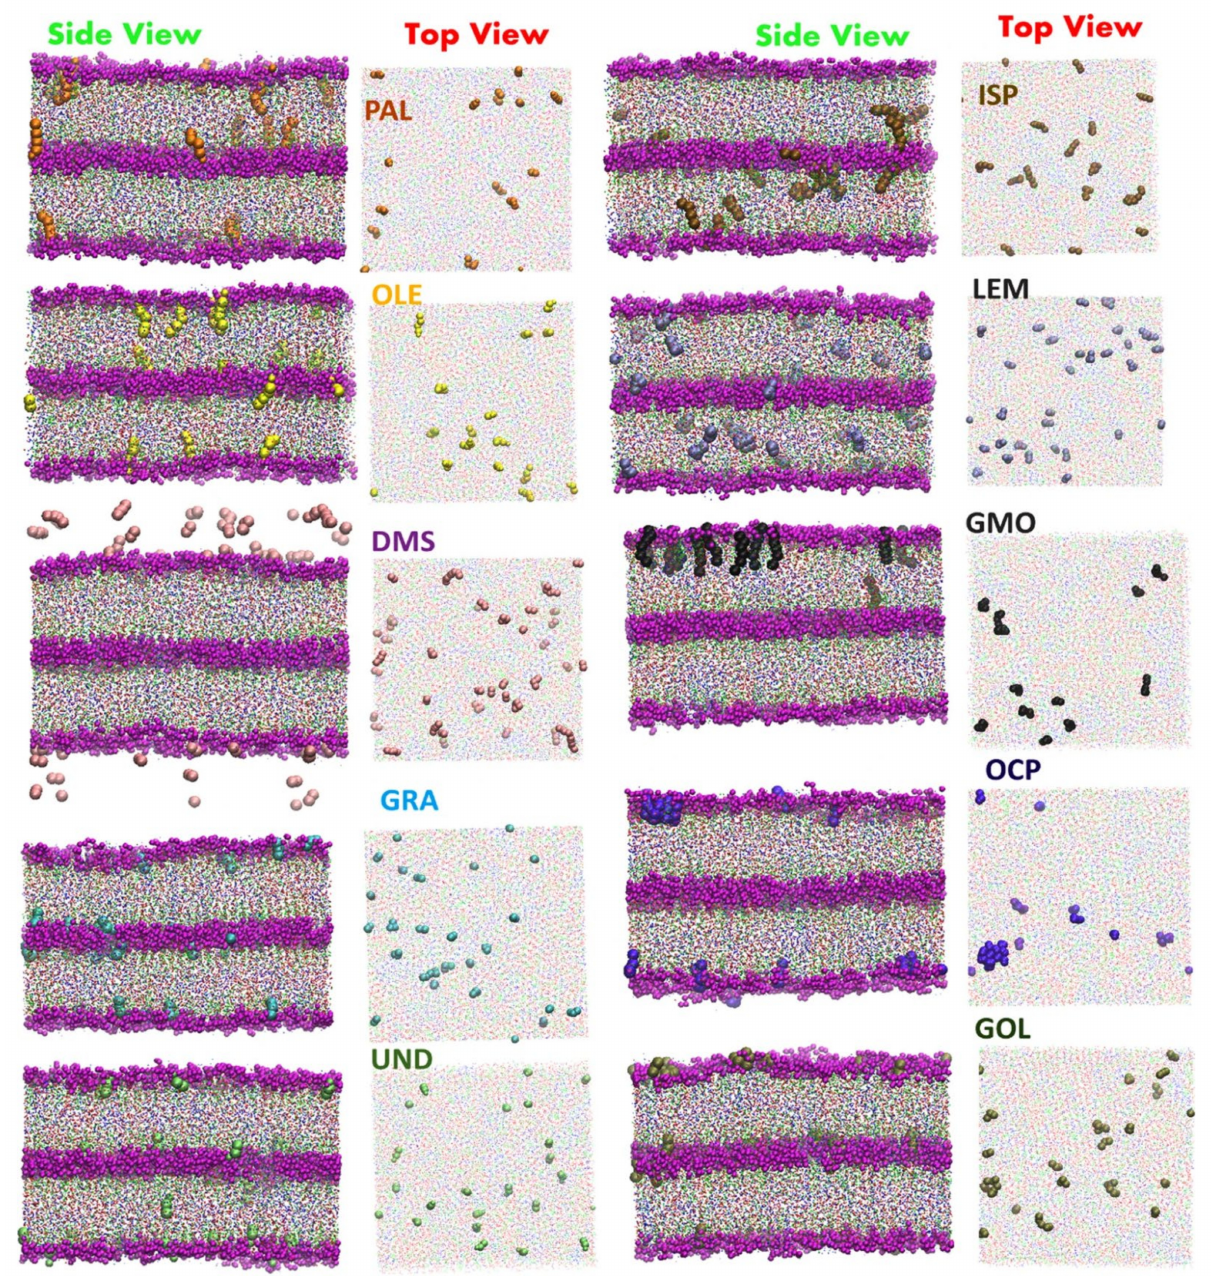
Figure 12. Snapshots of the stratum corneum model with selected enhancers: Oleic Acid (OLE), Palmitic Acid (PLA), Geranic Acid (GRA), Undecanoic acid (UND), DMSO (DMS), Geraniol (GOL), Glycerylmonooleate (GMO), Isopropyl palmiate (ISP), Limonene (LEM), and Octyl pyrrolidone (OCP). Reproduced from ref.